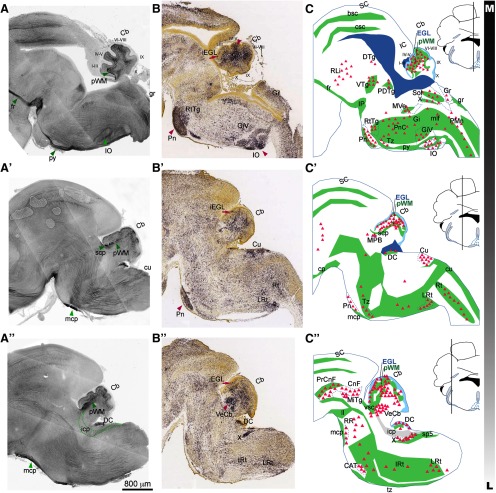
 At birth, CB1 is prominently expressed in axon tracts in hindbrain. A–A”, Immunolocalization of CB1 in sagittal hindbrain sections spanning cerebellar vermis and paravermis at P0 shows robust expression in developing axons, including long-range axon tracts in the brainstem and in the fibers cruising through the inner regions of the developing cerebellar cortex. Immediately relevant for the developing pontocerebellar system, CB1 immunolocalization is seen in mcp and scp [mcp (A”) and scp (A’), highlighted by green arrowheads], and in axons filling pWM (A–A”, green arrowheads). CB1 expression in icp (A”, green dotted outline) is very weak or absent. B–B”, Sagittal sections showing localization of CB1 mRNA in the hindbrain at E18 from the Allen Brain Atlas Developmental Mouse database (2008 Allen Institute for Brain Science. Allen Developing Mouse Brain Atlas, available from http://developingmouse.brain-map.org/experiment/show/100024806). Notably for pontocerebellar development, CB1 mRNA expression is prominent both in the Pn (B, maroon arrowhead) and the IO (B, maroon arrowhead), among many other brainstem nuclei which project axons to the cerebellum (marked by maroon triangles and anatomic abbreviations in summary diagrams in panels C–C”). In the cerebellum, CB1 mRNA is most prominent in deeper layers (B, maroon arrowhead). CB1 mRNA positive region spans developing IGL and pWM, marked in summary diagram in C. CB1 mRNA expression is also prominent in vestibulocerebellar nucleus (VeCb; B”, maroon arrowhead). In addition, restricted regions of the iEGL (B–B”, maroon arrow) show thin layer of CB1-positive cells. C–C”, Traced outlines of sections shown in A, summarizing perinatal distribution of CB1 expression relative to anatomic landmarks. Green shapes mark CB1 immunolocalization in axon tracts as shown in A, red triangles mark brain regions with robust CB1 mRNA expression as shown in B. Lines in coronal insets represent mediolateral plane of sectioning. Anatomical locations are adapted from Franklin and Paxinos (2008) and from Paxinos et al. (2007). bsc, brachium of superior colliculus; CAT, nucleus of the central acoustic tract; CB, cerebellum; CnF, cuneiform nucleus; cp, cerebral peduncle; csc, commissure of superior colliculus; Cu, cuneate nucleus; DC, dorsal cochlear nucleus; DTg, dorsal tegmental nucleus; fr, fasciculus retroflexus; Gi, gigantocellular reticular nucleus; GiV, gigantocellular reticular nucleus, ventral part; g, gracile fasciculus; Gr, gracile nucleus; icp, inferior cerebellar peduncle; IC, inferior colliculus; IO, inferior olivary nucleus; IP, interpeduncular nucleus; IRt, intermediate reticular nucleus; ll, lateral lemniscus; LRt, lateral reticular nucleus; mcp, middle cerebellar peduncle; mcp, middle cerebellar peduncle; MiTg, microcellular tegmental nucleus; mlf, medial longitudinal fasciculus; MPB, medial parabrachial nucleus; MVe, medial vestibular nucleus, magnocellular part; PDTg, posterodorsal tegmental nucleus; PMn, paramedian reticular nucleus; Pn, pontine nucleus; PnC, pontine reticular nucleus, caudal part; PrCnF, precuneiform area; py, pyramidal tract; RLi, rostral linear nucleus (midbrain); RR, retrobulbar nucleus; Rt, reticular nucleus; RtTg, reticulotegmental nucleus of the pons; SC, superior colliculus; scp, superior cerebellar peduncle; Sol, solitary nucleus; sp5, spinal trigeminal tract; Tz, nucleus of the trapezoid body; tz, trapezoid body; VeCb, vestibulocerebellar nucleus; vsc, ventral spinocerebellar tract; VTg, ventral tegmental nucleus; X, nucleus X, dorsal nucleus of the vagus nerve.